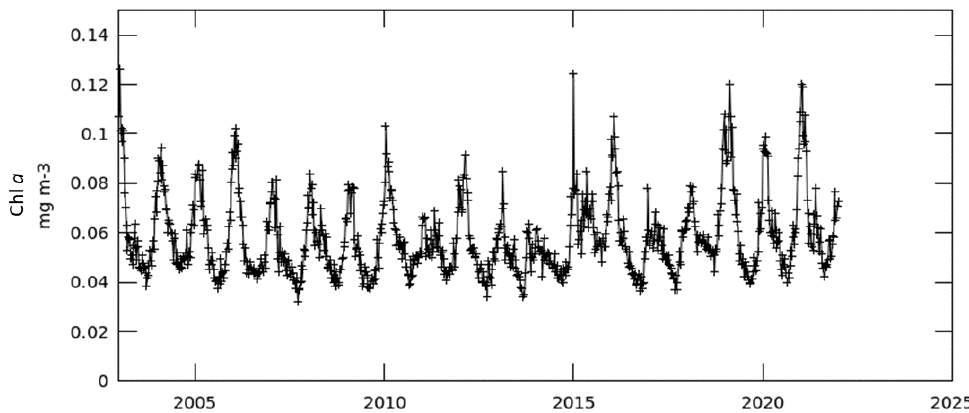
Figure 3. MODIS-Aqua chl a climatology for the Chuuk Lagoon-Pohnpei region (151.2 E, 6 N, 163.2 E, 8 N) for the period 2003 – 2021. As is expected for an oligotrophic ocean waters, chl a is normally very low.